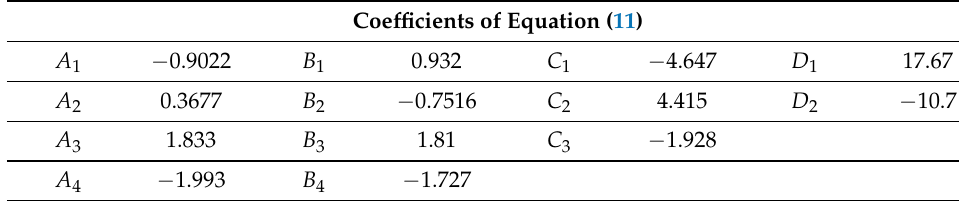
Table 2. Coefficients for the fitting of equation given in Equation